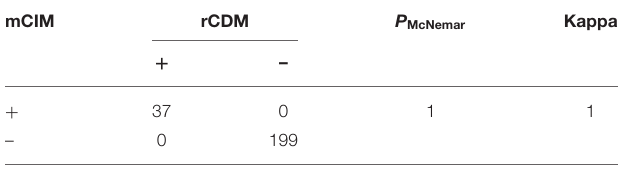
TABLE 8 | The statistic results of mCIM and rCDM for 236 P. aeruginosa isolates. mCIM rCDM P McNemar